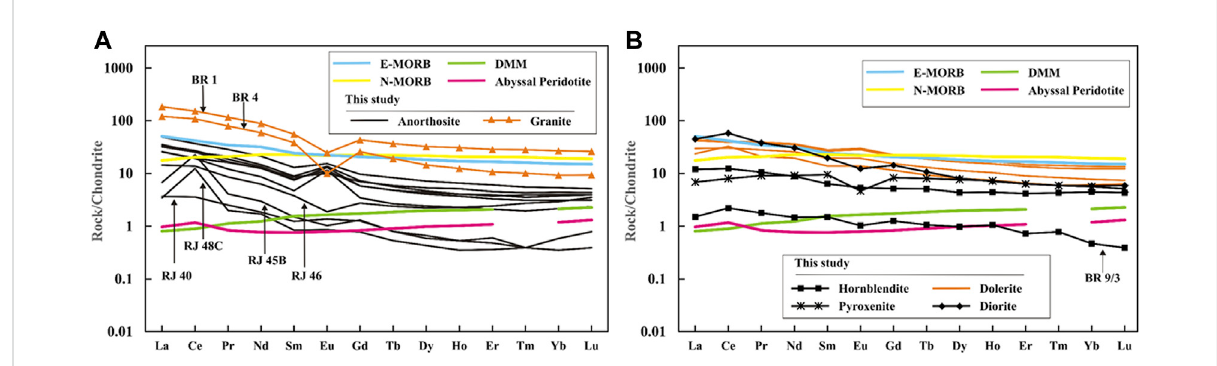
FIGURE 10 Chondrite normalized whole-rock rare earth element patterns for (A) anorthosite and granite samples and (B) hornblendite, pyroxenite, dolerite,anddioritesamplesfromtheChotanagpurGraniteGneissComplex(CGGC).Graniteandgabbro fi eldsforCGGC,enriched-MORB,normal- MORB, depleted MORB mantle, abyssal peridotite, and normalizing values are the same as in Figure 8.